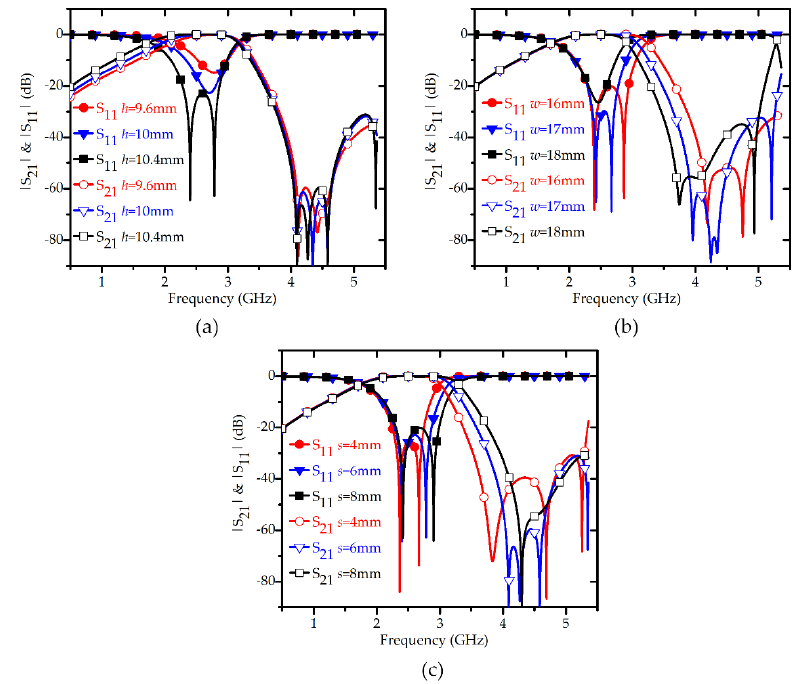
Figure 4. Simulated results at varying parameters h, w and s ( a ) h varies; ( b ) w varies; ( c ) s